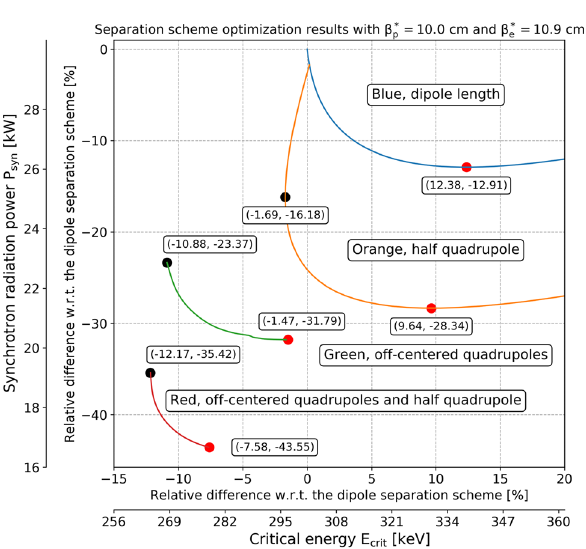
Fig. 19 Optimisingthesynchrotron lightforlowestcriticalenergyand power in the IR, details in the text